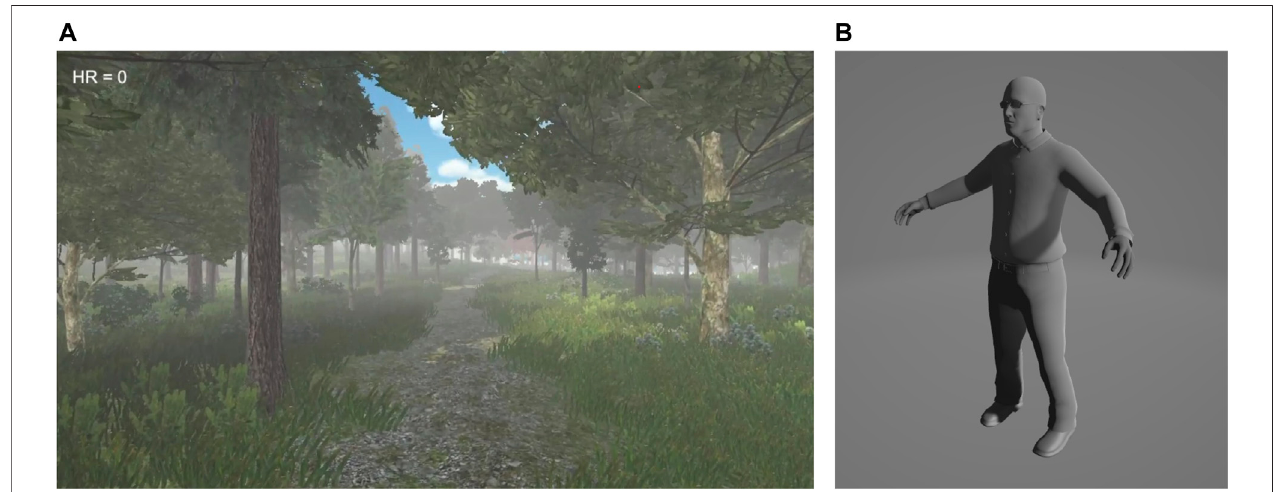
FIGURE 2 | The Virtual Reality application. (A) Shows Virtual Meditative Walk (VMW) environment: Patients ’ will “ walk ” or fl oat through a forest during their VR intervention. (B) Shows a senior-male model used as an avatar in the VMW. Skin colour will be chosen based on the participant ’ s skin tone.